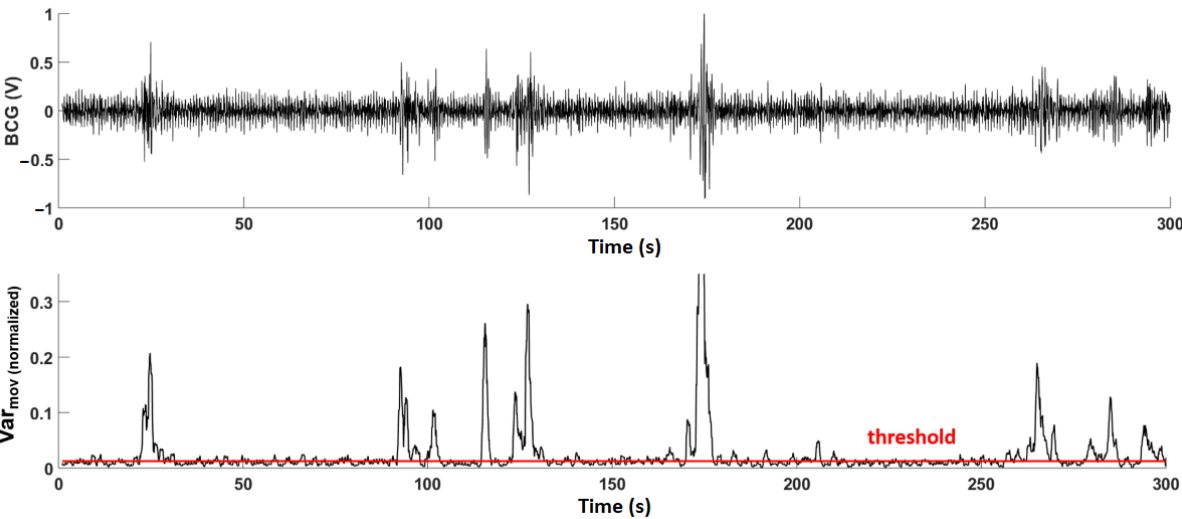
Figure 3. Five minutes of ballistocardiography data obtained from a participant (top). The moving windowed variance function applied to the signal. Signal segments above the threshold were discarded (bottom). BCG: ballistocardiography; Var: variance.